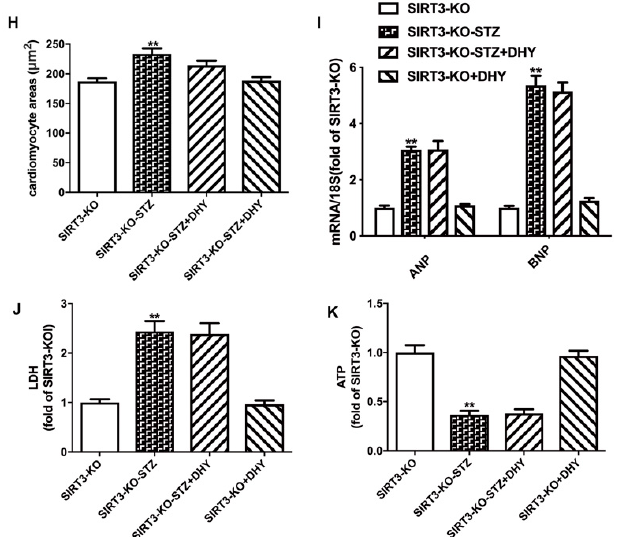
Figure 7. DHY failed to alleviate diabetic cardiomyopathy in STZ-induced SIRT3-KO mice. Male 8-week-old SIRT3-KO mice were injected with STZ (60 mg/kg/day) for 5 consecutive days. Mice in control group were injected the same amount of citrate buffer. DHY (250 mg/kg) or carboxymethyl- cellulose (CMC, 0.5%) were administrated 2 weeks later, once daily by gavage for 12 weeks. ( A ) Rep- resentative echocardiographs of two-dimensional M-mode and Doppler of mice. ( B ) EF. ( C ) FS. ( D ) E/A ratio. ( E – G ) The representative images of the myocardium with HE staining (bar = 100 µ m), sirus red staining (bar = 100 µ m) and Masson’s staining (bar = 20 µ m). ( H ) Cardiomyocyte areas. ( I ) Expression of ANP and BNP mRNA. ( J ) LDH in the serum. ( K ) ATP level in the myocardium. ** p < 0.01 versus